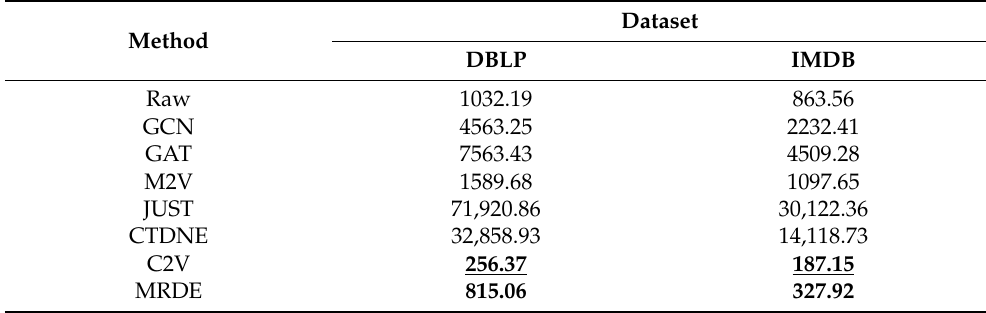
Table 4. Clustering task running time (in seconds).